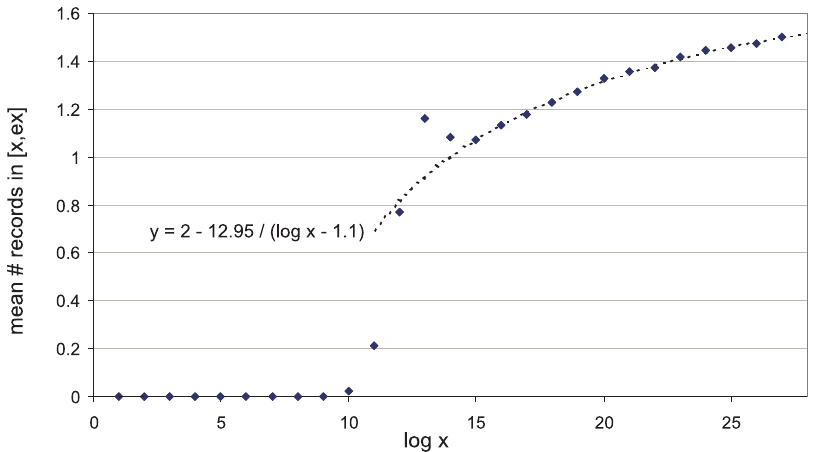
Figure 6. Primes p = r + nq , k = 1, q = 16001. Mean number of maximal gaps G q , r observed for p ∈ [ x , ex ] , x = e j , j ≤ 27. Averaging for all H -allowed r . Dotted curve is a hyperbola with horizontal asymptote y = 2.